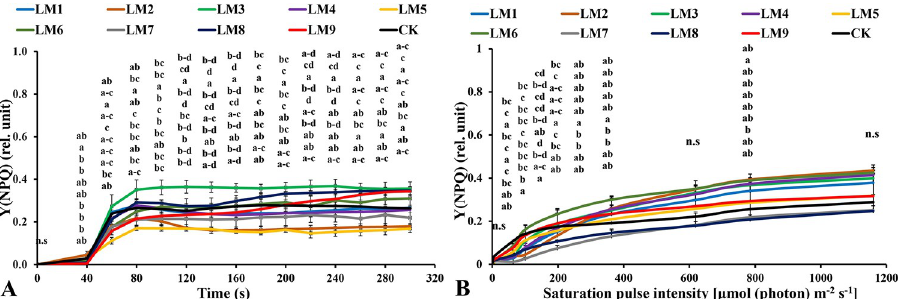
Fig 7. Effects of LED light modes on chlorophyll a fluorescence induction kinetics of the dark-acclimated (A) and RLC of the light-acclimated (B) of quantum yield of regulatory energy dissipation in PSII Y(NPQ) in rocket leaves. The points are means ± SE of 4 replicates followed by the same letters meaning no different significantly according to the Duncan test (P � 0.05). Sort significance letters from top to bottom according to the treatments (ML1-CK). LM1 = A1: B1:C1, LM2 = A1:B2:C2, LM3 = A1:B3:C3, LM4 = A2:B1:C2, LM5 = A2:B2:C3, LM6 = A2:B3:C1, LM7 = A3:B1:C3, LM8 = A3:B2:C1, LM9 = A3:B3:C1, CK = White fluorescent